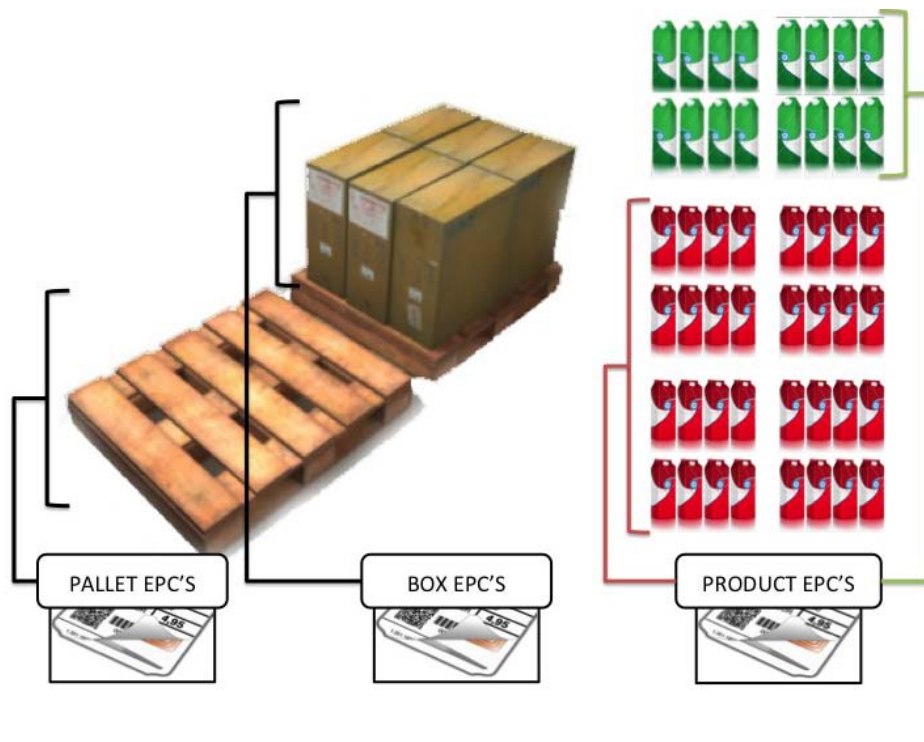
Figure 20. Conditional Block-wise product specification.